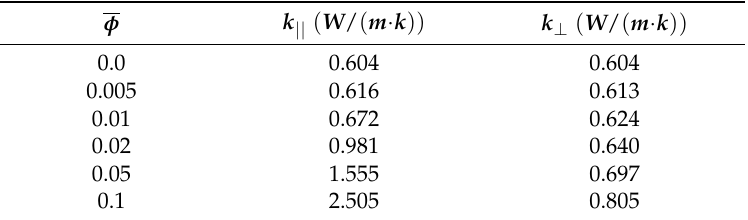
Table 4. The values of the thermal conductivity of the nanofluid paralell and perpendicular to the magnetic field with different nanoparticles concentrations.